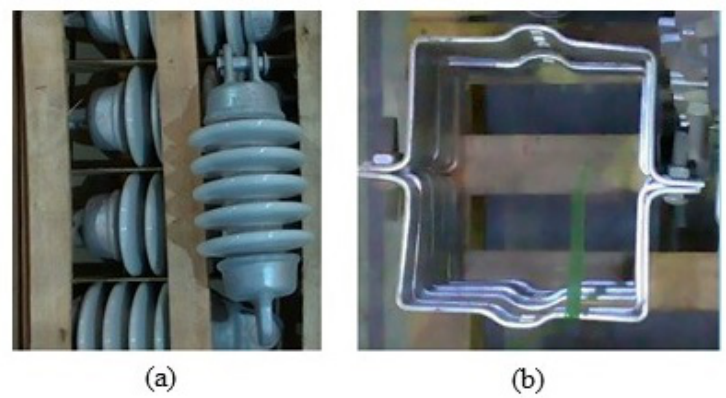
Figure 7. Classes: ( a ) utility pole insulators and ( b ) brace